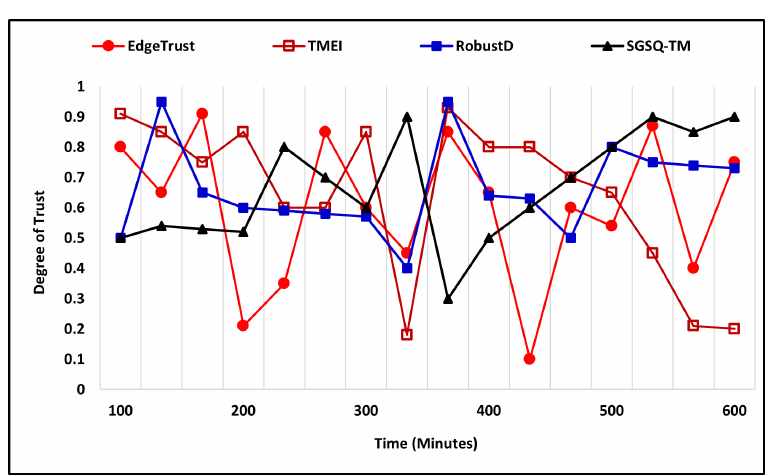
Figure 11. Good mouthing attacks with varying nodes